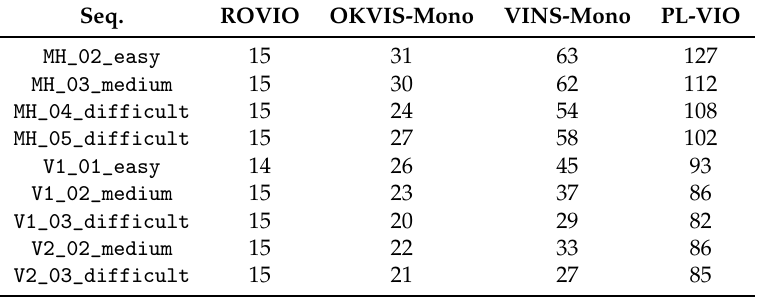
Table 2. Average running times of different methods on the EuRoc dataset (unit: millisecond). Seq. ROVIO OKVIS-Mono VINS-Mono PL-VIO